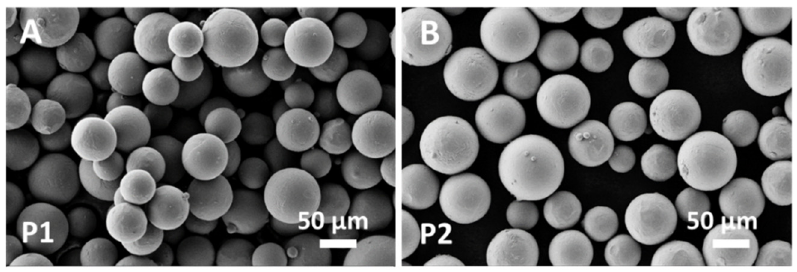
Figure 2. FESEM images of powders: ( A ) blended P1 and ( B ) virgin new P2.